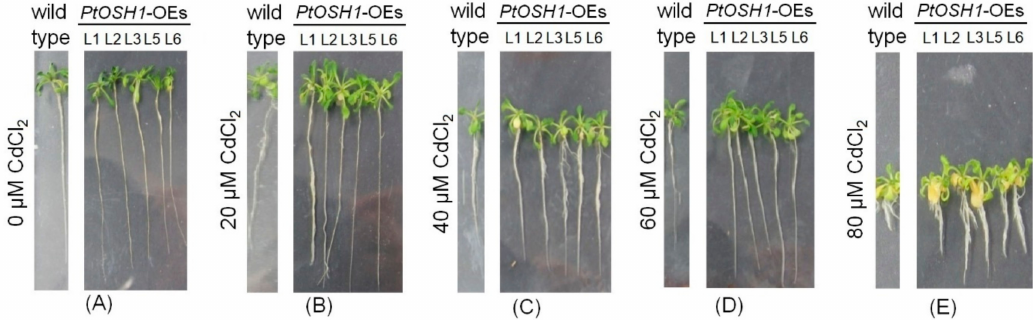
Figure 5. Phenotypic analysis of wild-type (WT) and transgenic A. thaliana lines (Line1 (L1), L2, L3, L5, L6) treated in 0 µ M Cd ( A ), 20 µ M Cd ( B ), 40 µ M Cd ( C ), 60 µ M Cd ( D ), and 80 µ M Cd ( E ). Three independent biological experiments were performed.